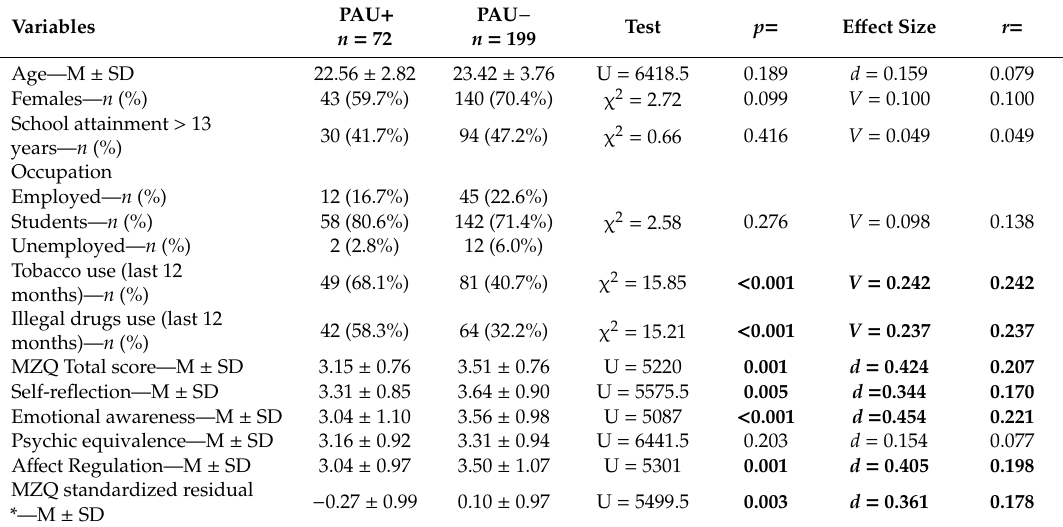
Table 2. Di ff erences between individuals with and with and without PAU according CAGE cut-o ff ≥ 1.